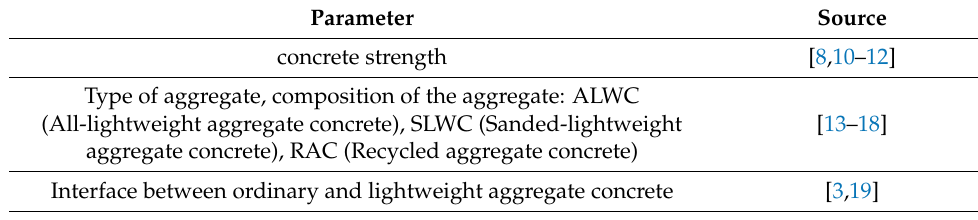
Table 1. Parameters considered in the previous experimental investigations.